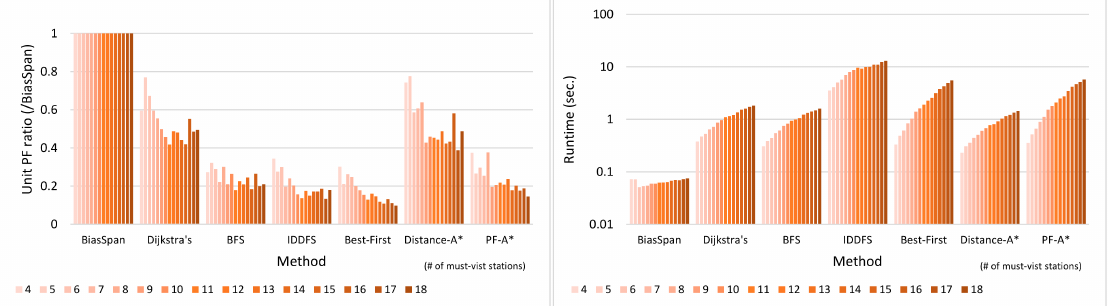
Figure 10. Unit PF ratio ( left ) and runtime ( right ) for different methods under area range in Tainan dataset. For methods with more than half failure cases, their performance would not be displayed.